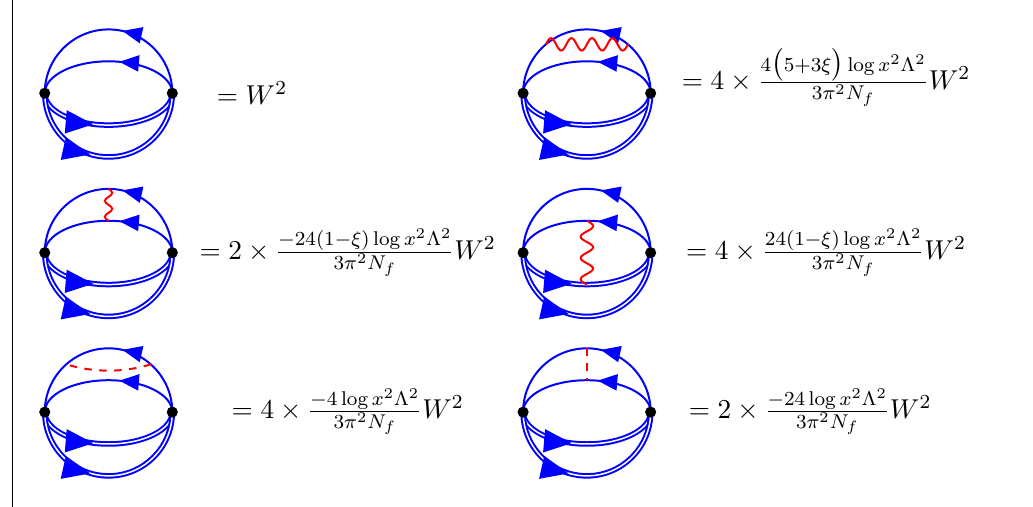
Table 6 . Renormalization of the ( sym ; sym ) quartic